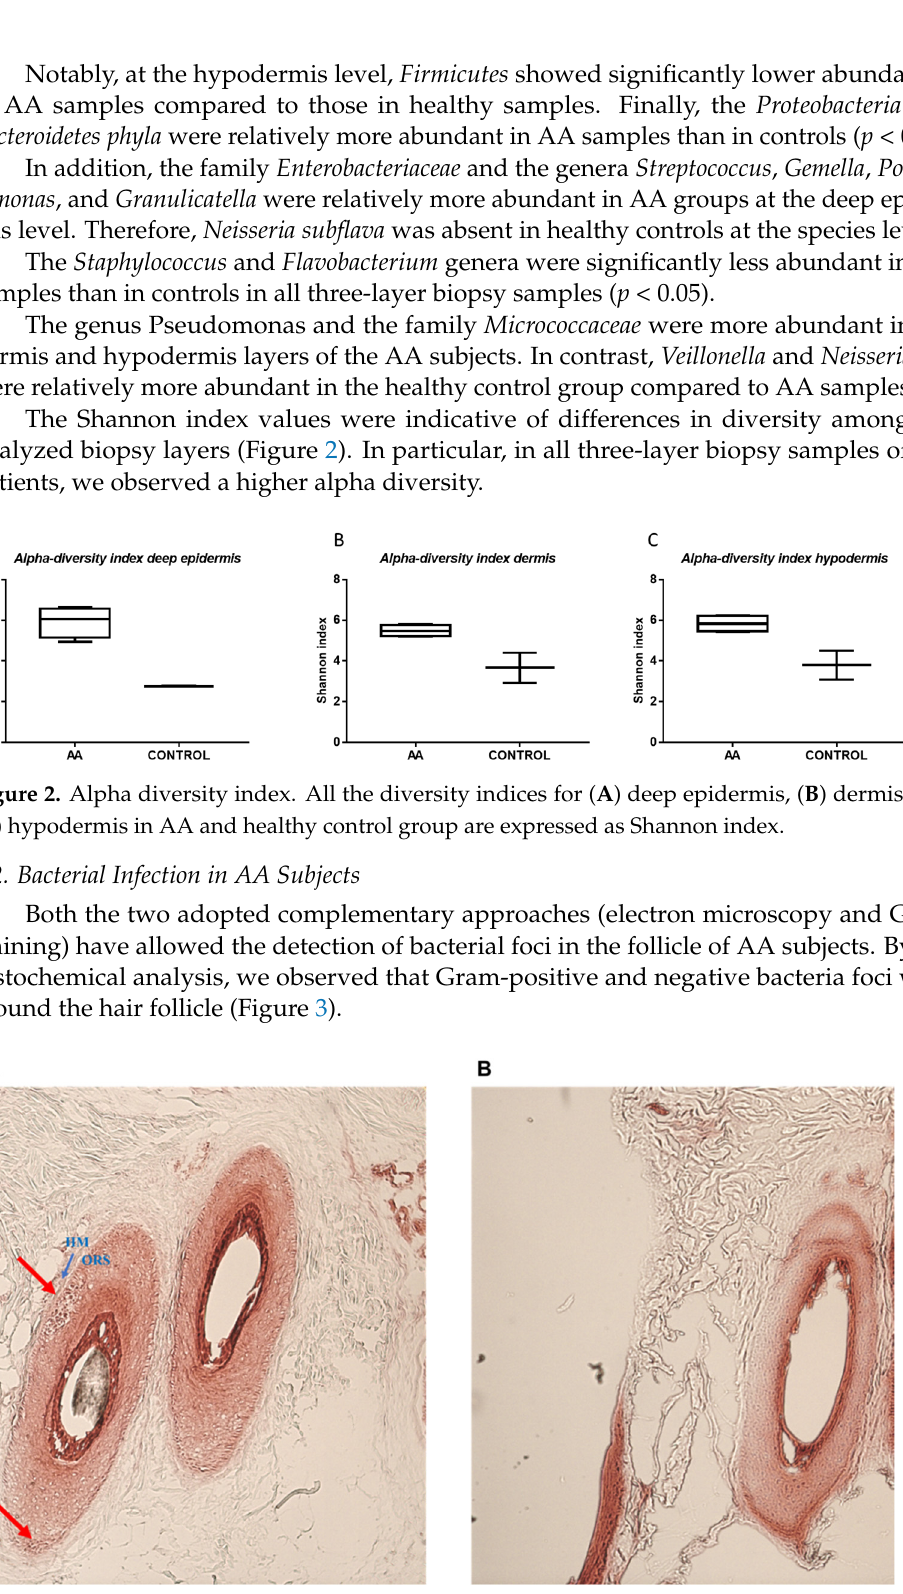
Figure 3. Gram staining. Hair follicles of AA patients ( A ) and control subjects ( B ) at the level of the isthmus showing bacterial foci (red arrow). HM: hyaline membrane (blue arrow); ORS: outer root sheet.